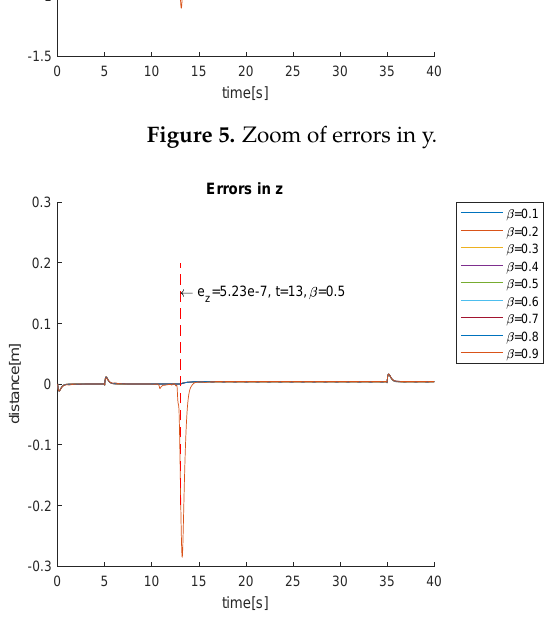
Figure 5. Zoom of errors in y.